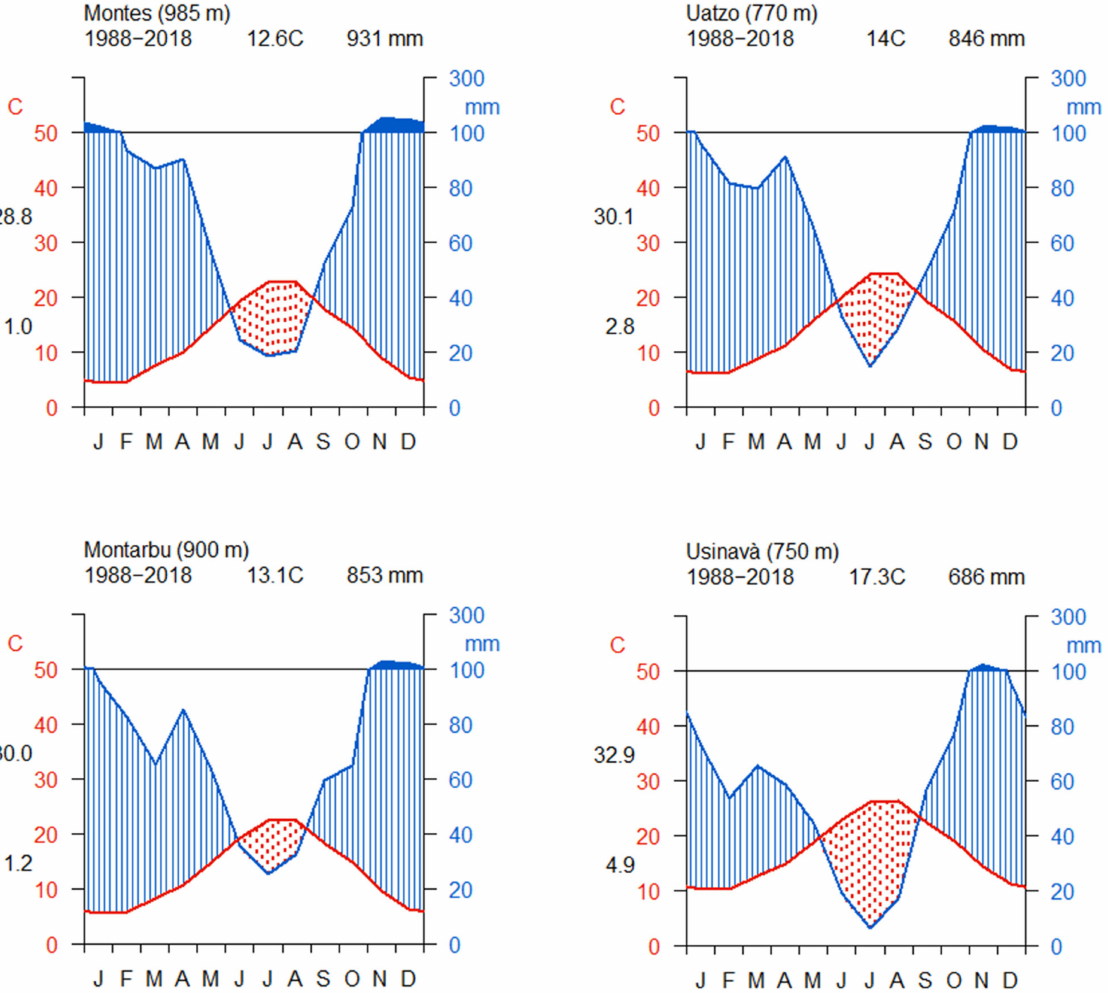
Figure 2. Walter and Lieth climate diagrams from 1988 to 2018 in the four common gardens. Daily maximum average temperature of the hottest month and daily minimum average temperature of the coldest month are labelled in black at the left margin of the diagram. The red line shows the mean temperature, while the total precipitation is reported in blue. The average temperature and the average precipitation are reported on top of the graphics. The red area represents the drought